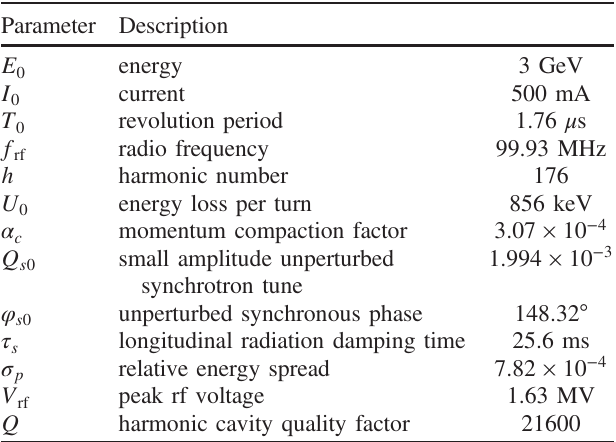
FIG. 2. Equilibrium density distribution for R Δ f ¼ − 60 . 36 kHz calculated with both scalar (solid line) and fully self-consistent (dashed line)